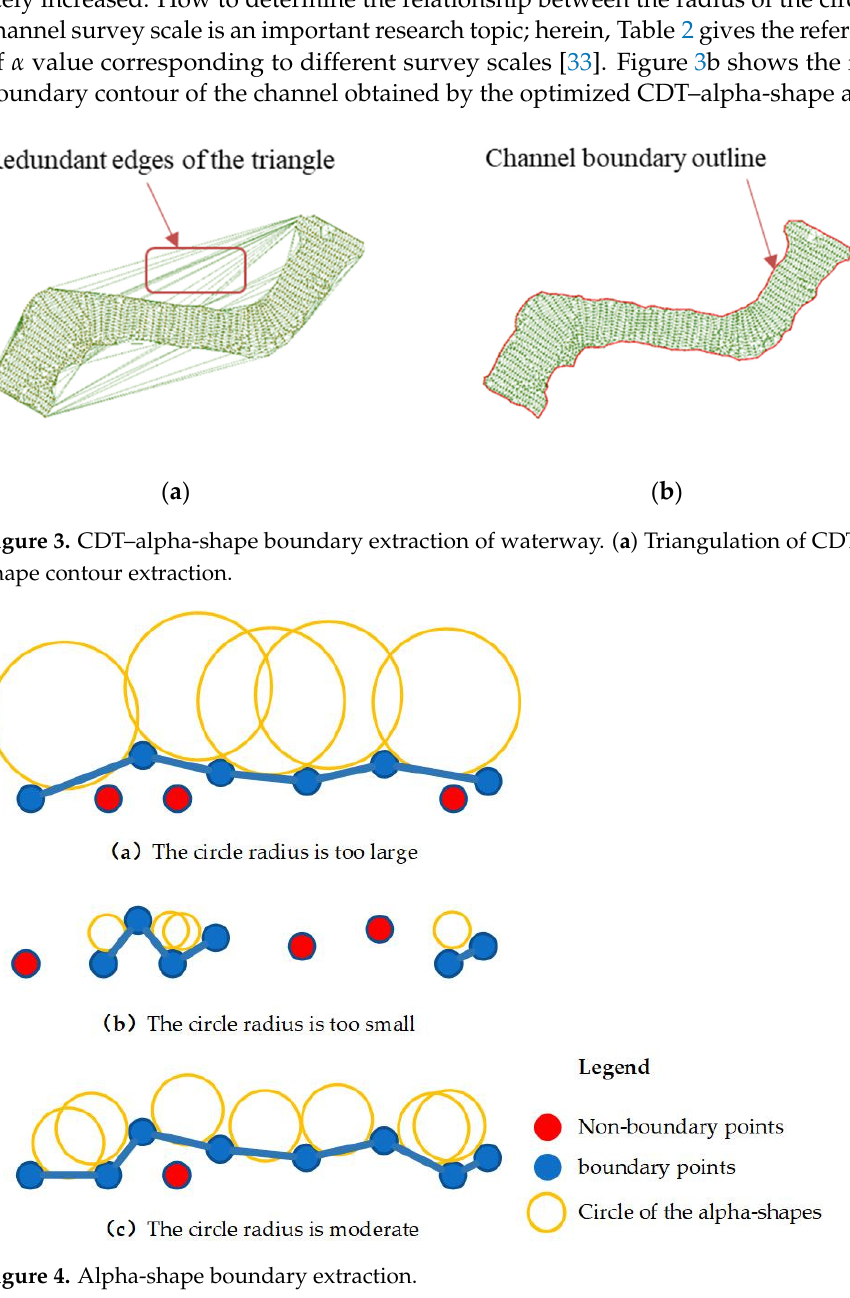
Figure 2. The flow of dynamic irregular grid division.